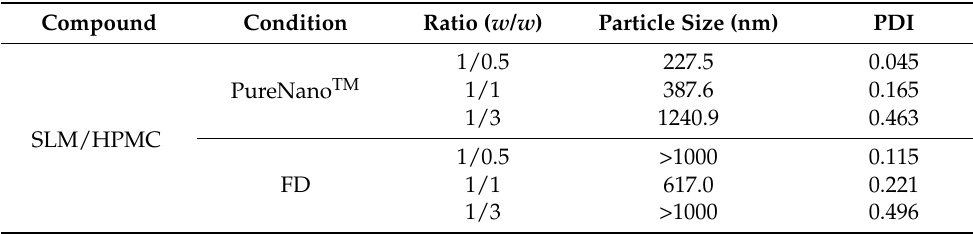
Table 3. Effect of hypromellose (HPMC) content on particle sizes of silymarin (SLM) suspensions prepared by PureNano TM and their freeze-dried (FD) samples.